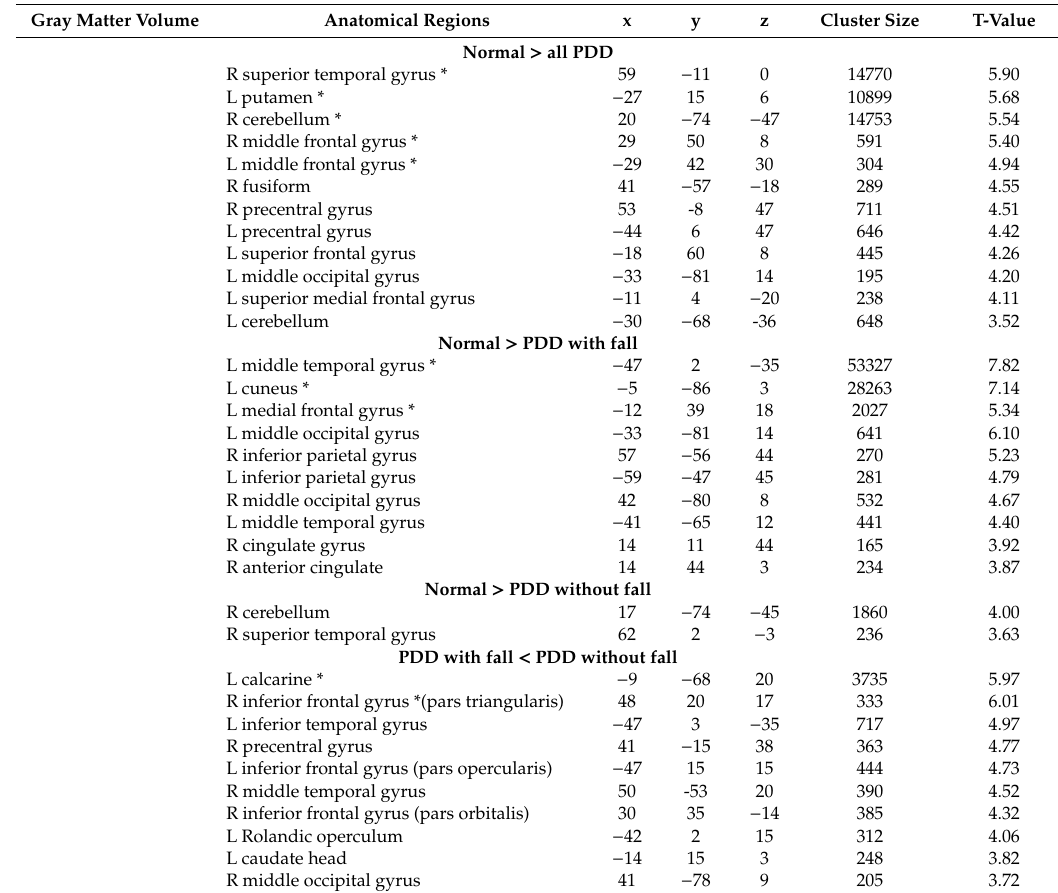
Table 3. Regions of statistically significant lower GMV in PD with dementia patients compared to those of